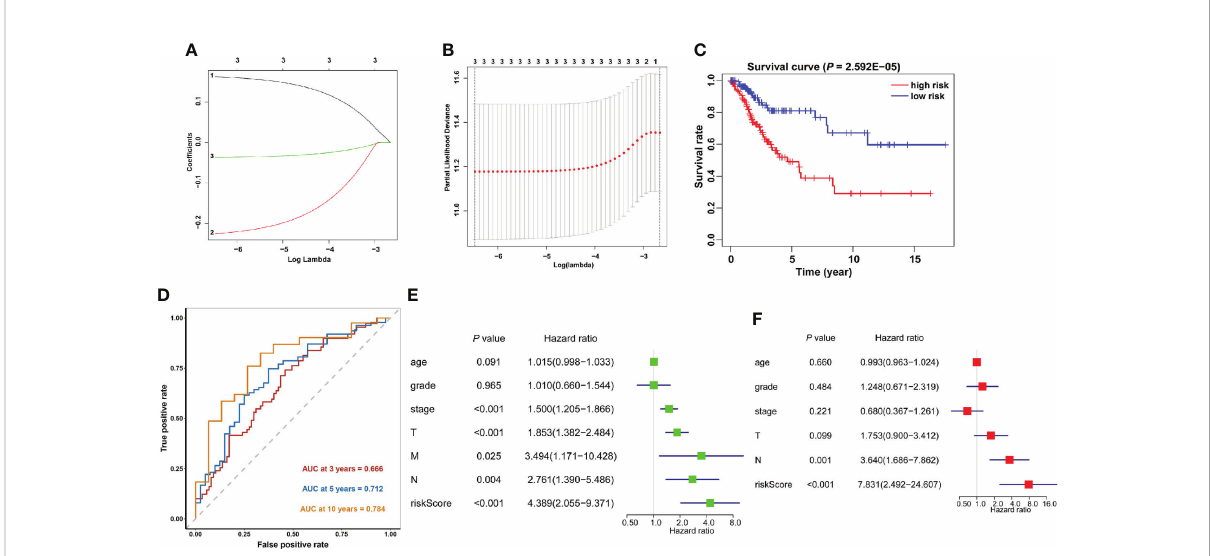
FIGURE 7 Construction of the prognostic signature based on the TCGA cervical cancer cohort. (A, B) The prognostic signature constructed by the minimum criterion of the LASSO Cox regression algorithm. (C) The Kaplan – Meier curve shows that the riskscore based on the prognostic signature of m6A RNA methylation is signi fi cantly correlated with OS in cervical cancer patients. (D) Time-dependent ROC curves were applied to assess the predictive ef fi ciency of the signature in TCGA. (E) Univariate and (F) multivariate Cox regression analysis of the riskscores in TCGA.